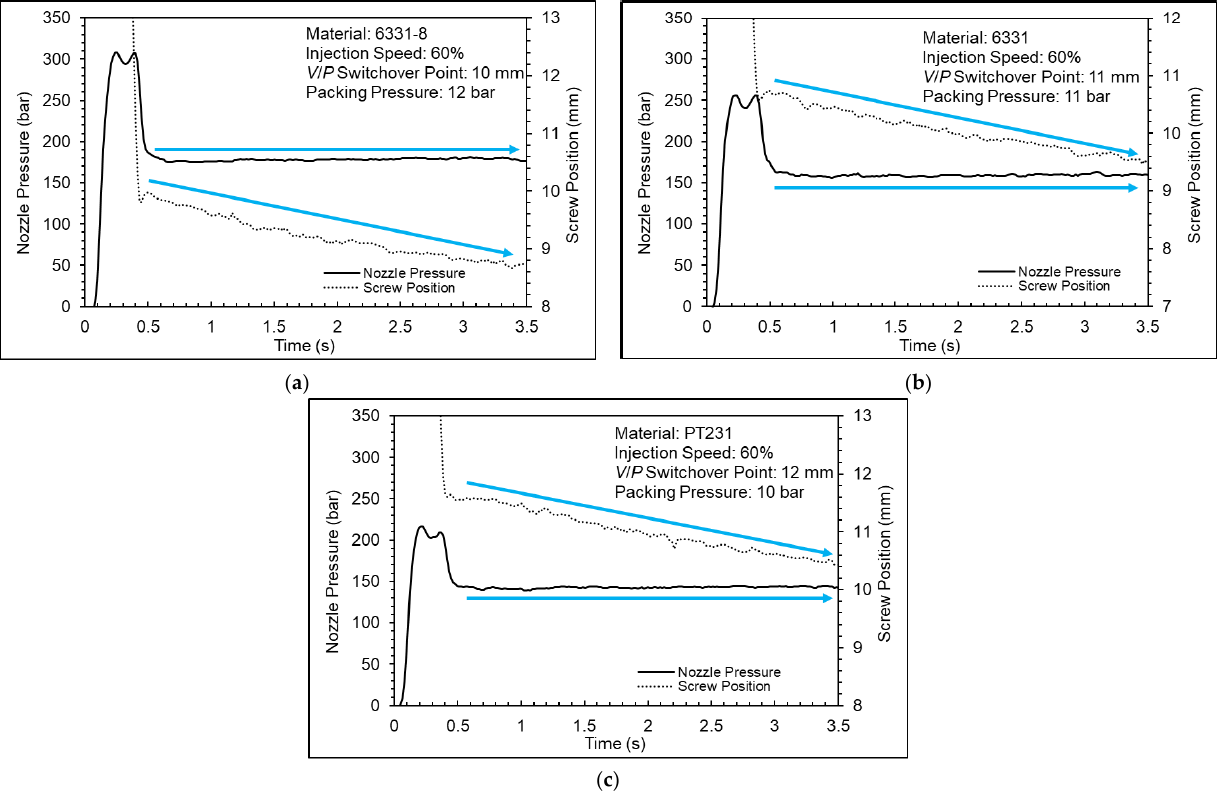
Figure 18. Nozzle pressure profile and screw stroke profile at the sufficient packing pressure (( a ) 6331 − 8, ( b ) 6331, and ( c ) PT231).